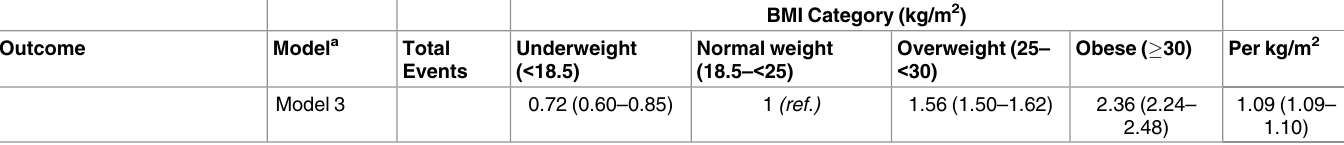
Abbreviations: BMI, body mass index; ICD, International Classification of Diseases. a Model adjustments as follows: Model 1 was adjusted for age at baseline ( < 20, 20– < 30, 30– < 40, 40+ years) and sex. Model 2 was adjusted as for Model 1, plus the following demographic covariates: race/ethnicity (white, black, Hispanic, Asian/Pacific Islander, Indian/Alaskan, other/unknown), educational attainment ( < high school, some college/college, advanced degree, other/unknown), and marital status (never married, married, divorced/separated/ widowed, other/unknown). Model 3 was adjusted as for Model 2, plus ICD-9 coding for behavioral risk factors (tobacco use, alcohol use) and other risk factors (depression, anxiety, posttraumatic stress disorder) reported prior to the outcome diagnosis. b Expressed as/in 100 person-months.